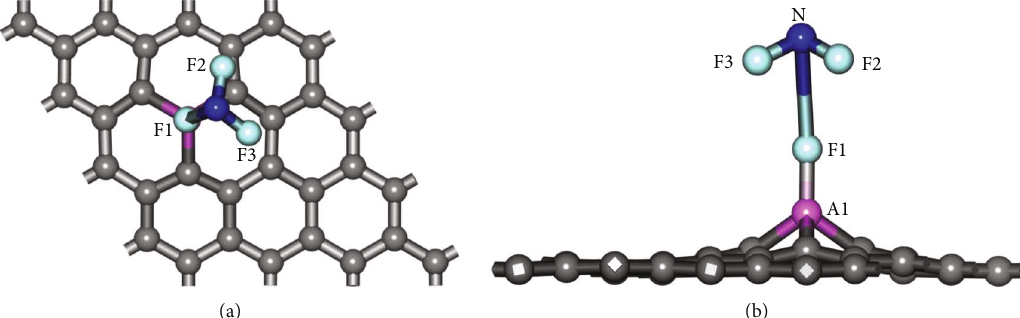
Figure 4: Adsorption con fi guration of NF adsorbed on Al-Graphene: (a) top view; (b) side view. 3 Table 2: The E , Q , and structural parameters of the NF ad t